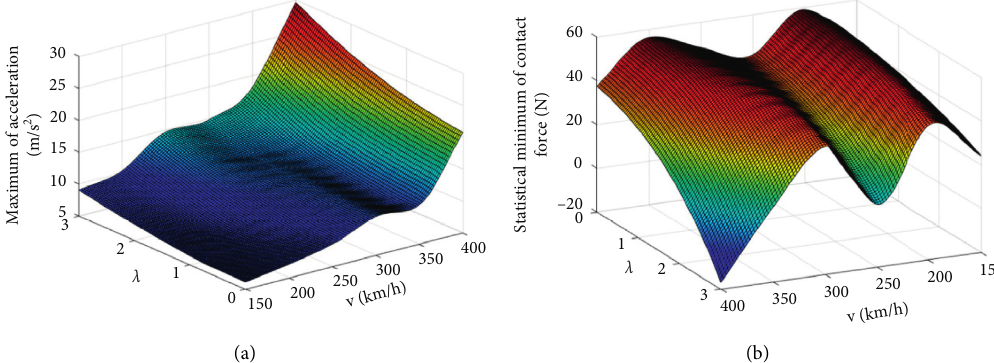
Figure 13: The influence of ice thickness on the current collection quality under different operating speeds (Uniform Load Method). (a). Maximum of acceleration, (b) statistical minimum of contact force.